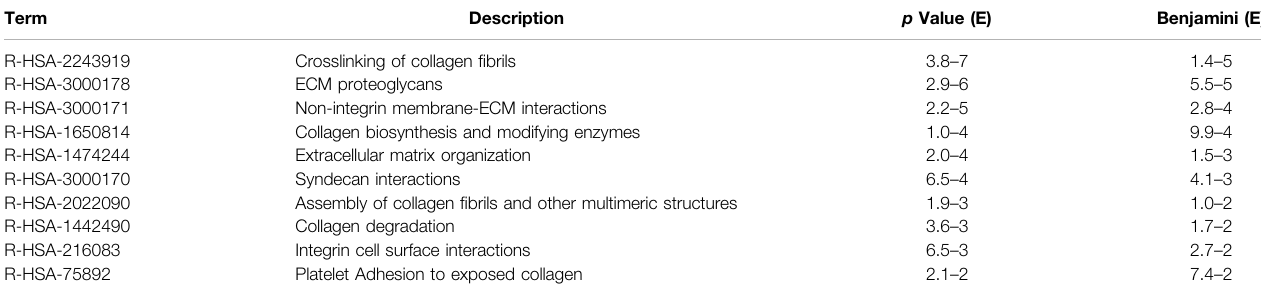
TABLE 2 | The function analysis of DEGs based on the REACTOME pathway analysis.